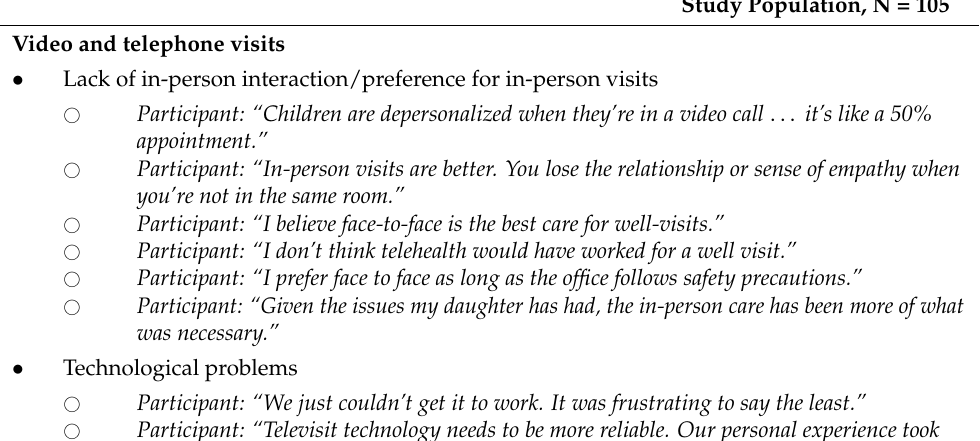
Table 3. Telehealth challenges, along with representative quotes by the caregivers. Video and telephone